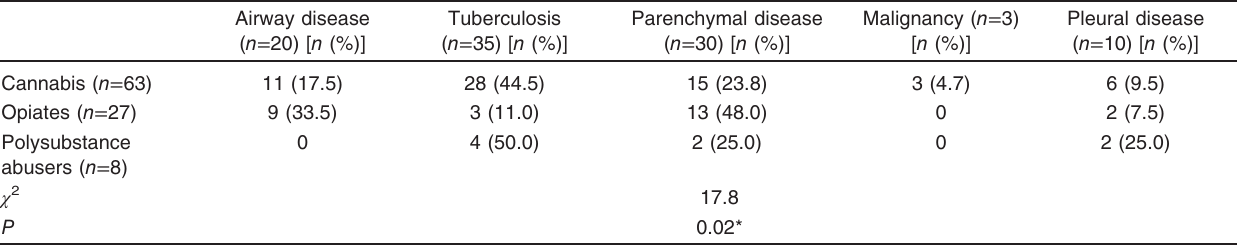
Table 3 Relation between different types of drug addiction and the pulmonary complications